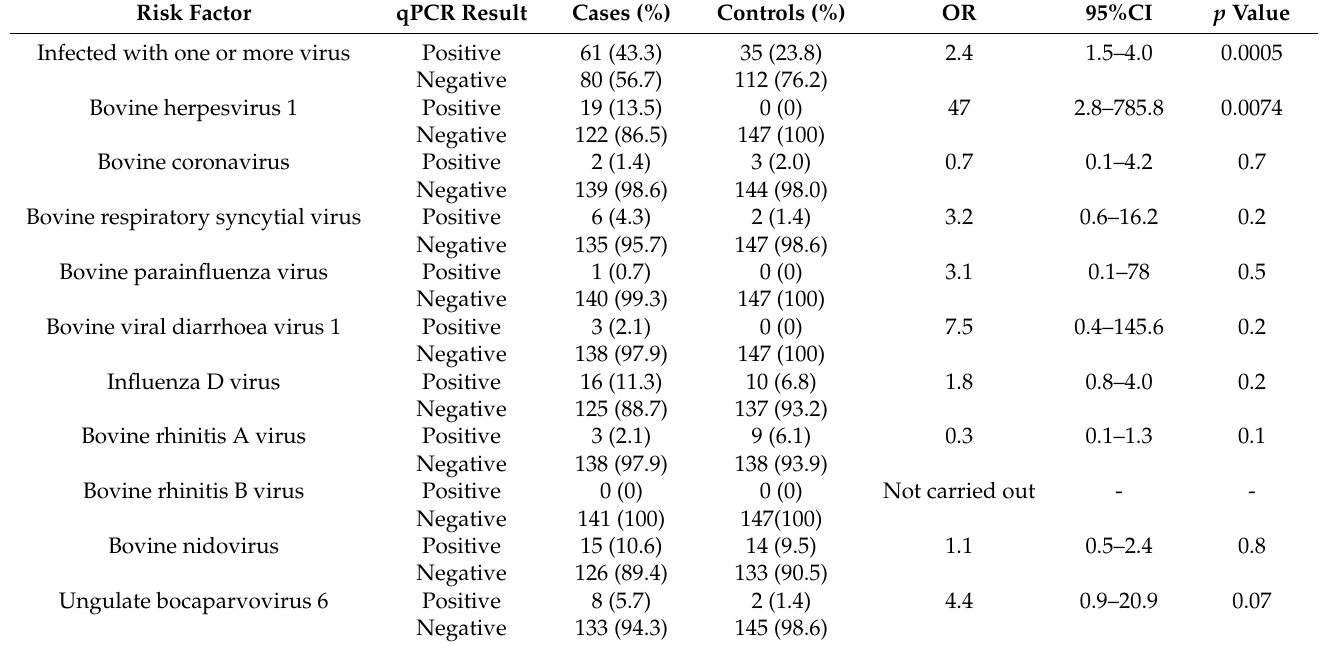
Table 5. Summary of the viral risk factors in the BRD case–control study. The qPCR-based detection of 10 viruses in the nasal swabs from cattle diagnosed with BRD (cases) and healthy cattle (controls) are summarised. Estimated odds ratios (OR) for the effect a positive qPCR result on the risk of the cattle being diagnosed with BRD. The 95% confidence intervals (95%CI) are shown for the risk factors, along with p values, with values <0.05 indicating a significant